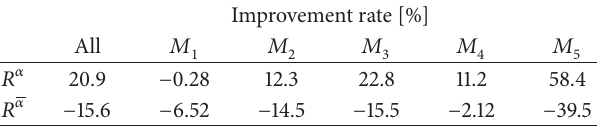
Table 3: Improvement rate (Experiment 1